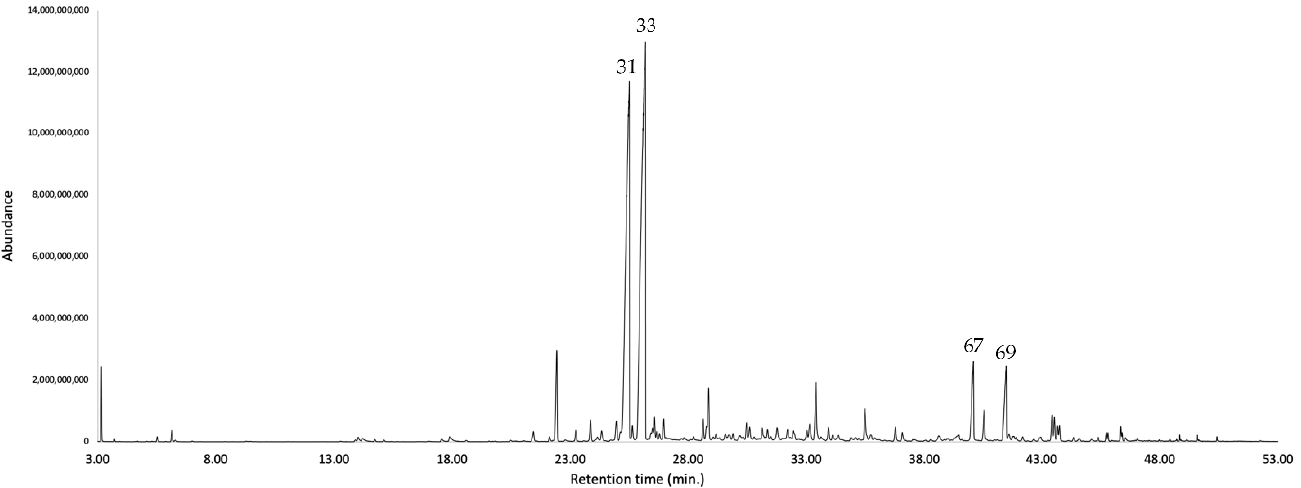
Figure 4. GC-MS chromatogram of K. longipetiolata EO on a 5%-phenyl-methylpolysiloxane stationary phase column. The peaks are numbered according to the order of oil components listed in Table 1.